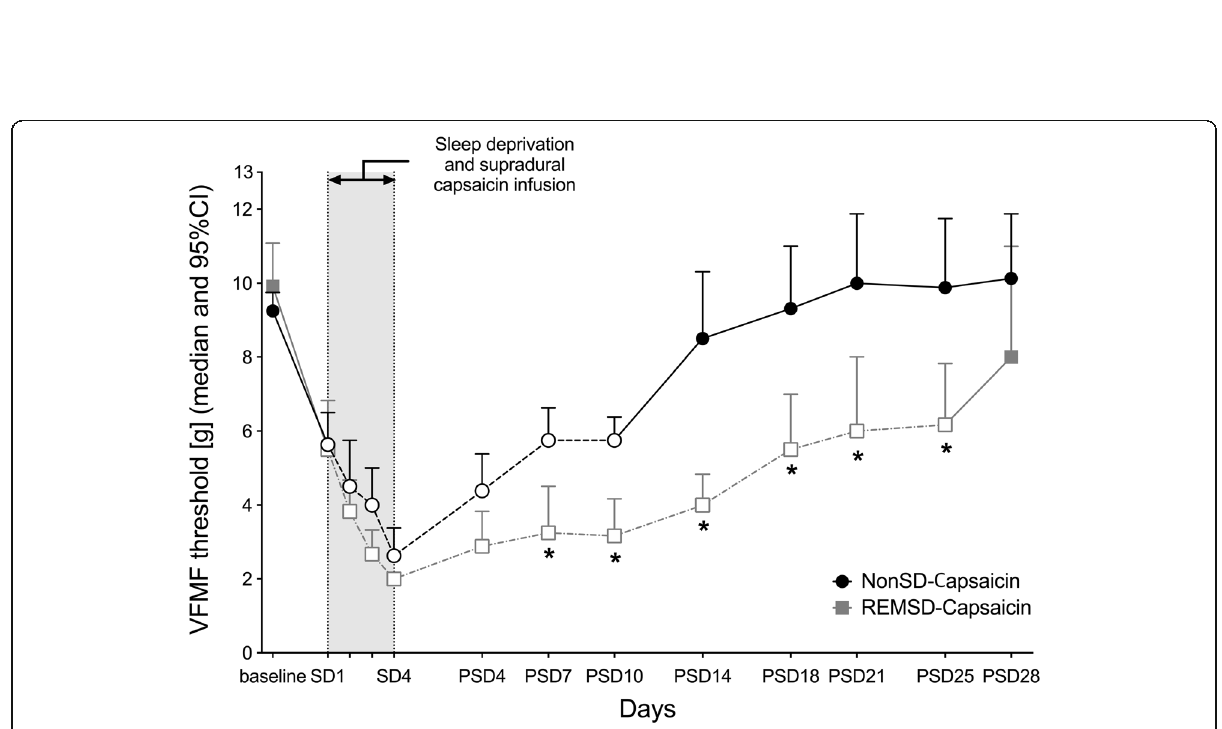
Fig. 4 The time course of the VFMF threshold level in each supradural capsaicin infusion group. The duration of reduced VFMF threshold in the REMSD-Capsaicin group was significantly longer than in the NonSD-Capsaicin group ( * indicates p < 0.05 between groups; blank circles and squares with a dotted-line indicate p < 0.05 compared to baseline, error bar indicates 95% confidence interval). Abbreviations: SD: days of sleep deprivation; PSD: days of post-sleep deprivation; [g]: